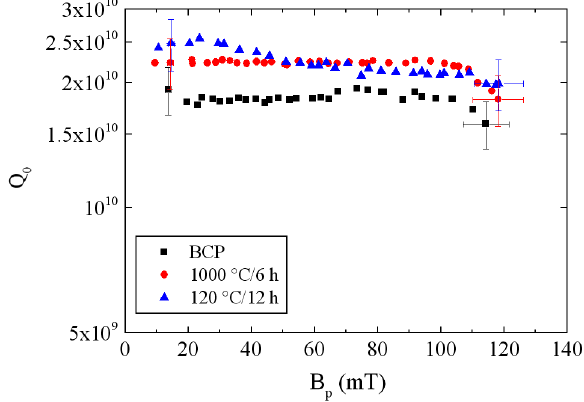
ð 2 : 0 K Þ vs B FIG. 5. Q p measured after etching by BCP, 0 followed by HT at 1000 (cid:1) C and by LTB.